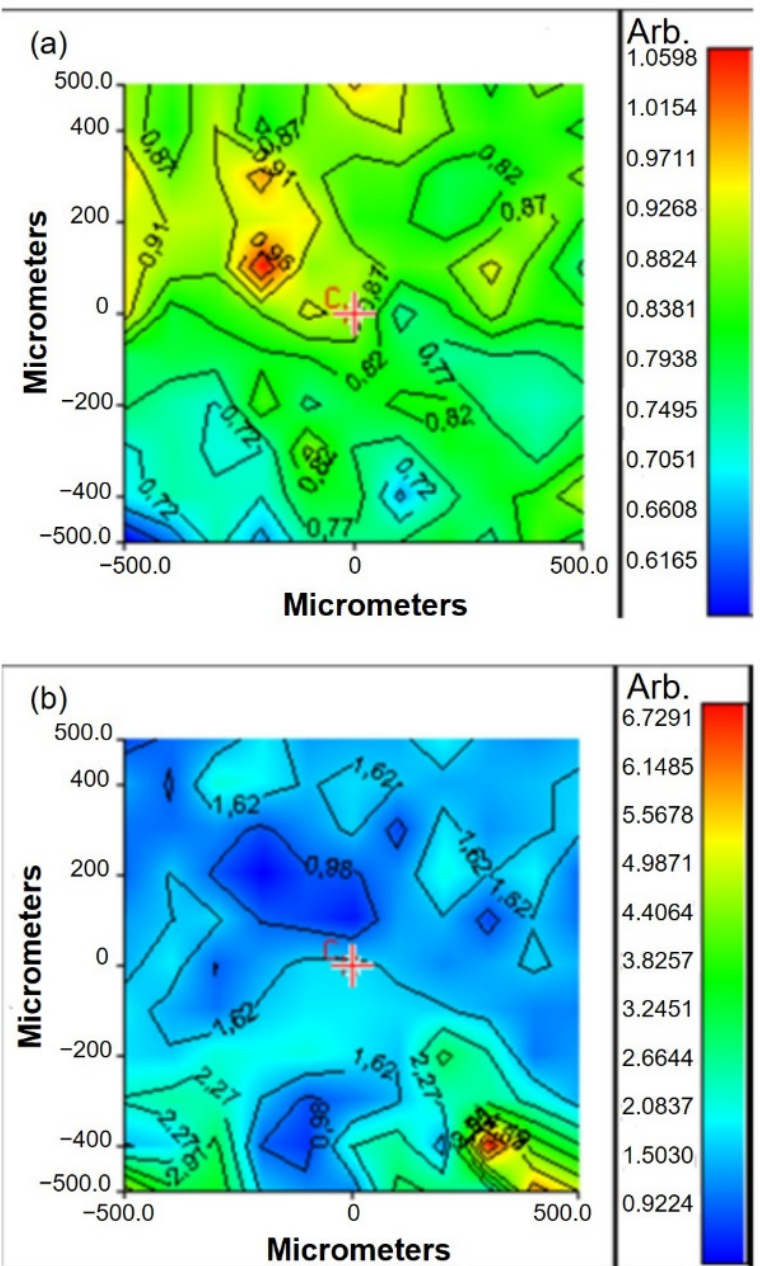
Figure 4. Chemical maps, in function of Am II/C-O-C band ratio, acquired: ( a ) before functionaliza- tion; ( b ) after functionalization.